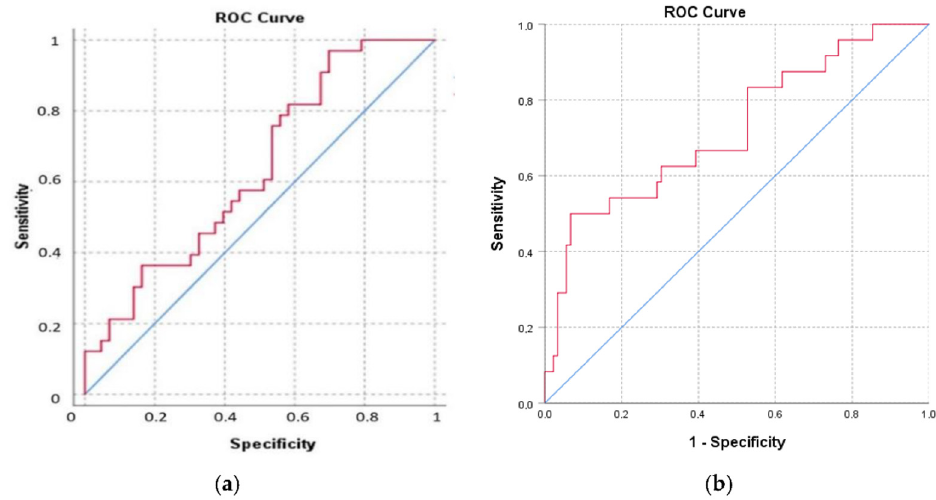
Figure 5. The area under the ROC curve for the TyG index as ( a ) a predictor of NASH; ( b ) a predictor of significant fibrosis (F2, F3, F4).